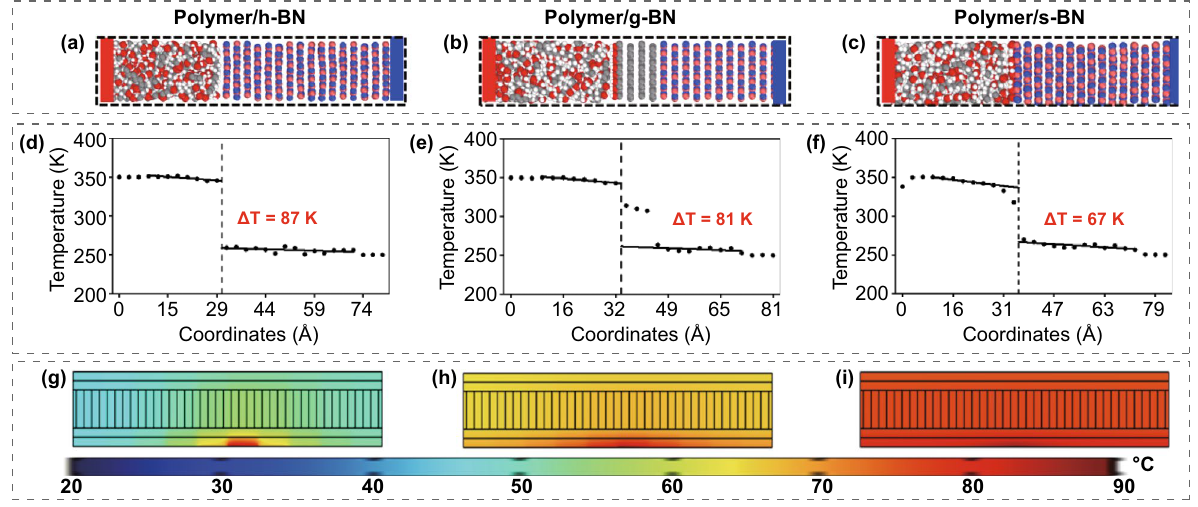
Fig. 4 Theoretical analysis of the interfacial thermal resistance between BN and polymers. a–c NEMD simulation models and d–f temperature configurations of the interfaces in polymer/h-BN, polymer/g-BN and polymer/s-BN composite films. g–i Finite element numerical simulation of heat conduction processes in polymer/h-BN, polymer/g-BN and polymer/s-BN composite